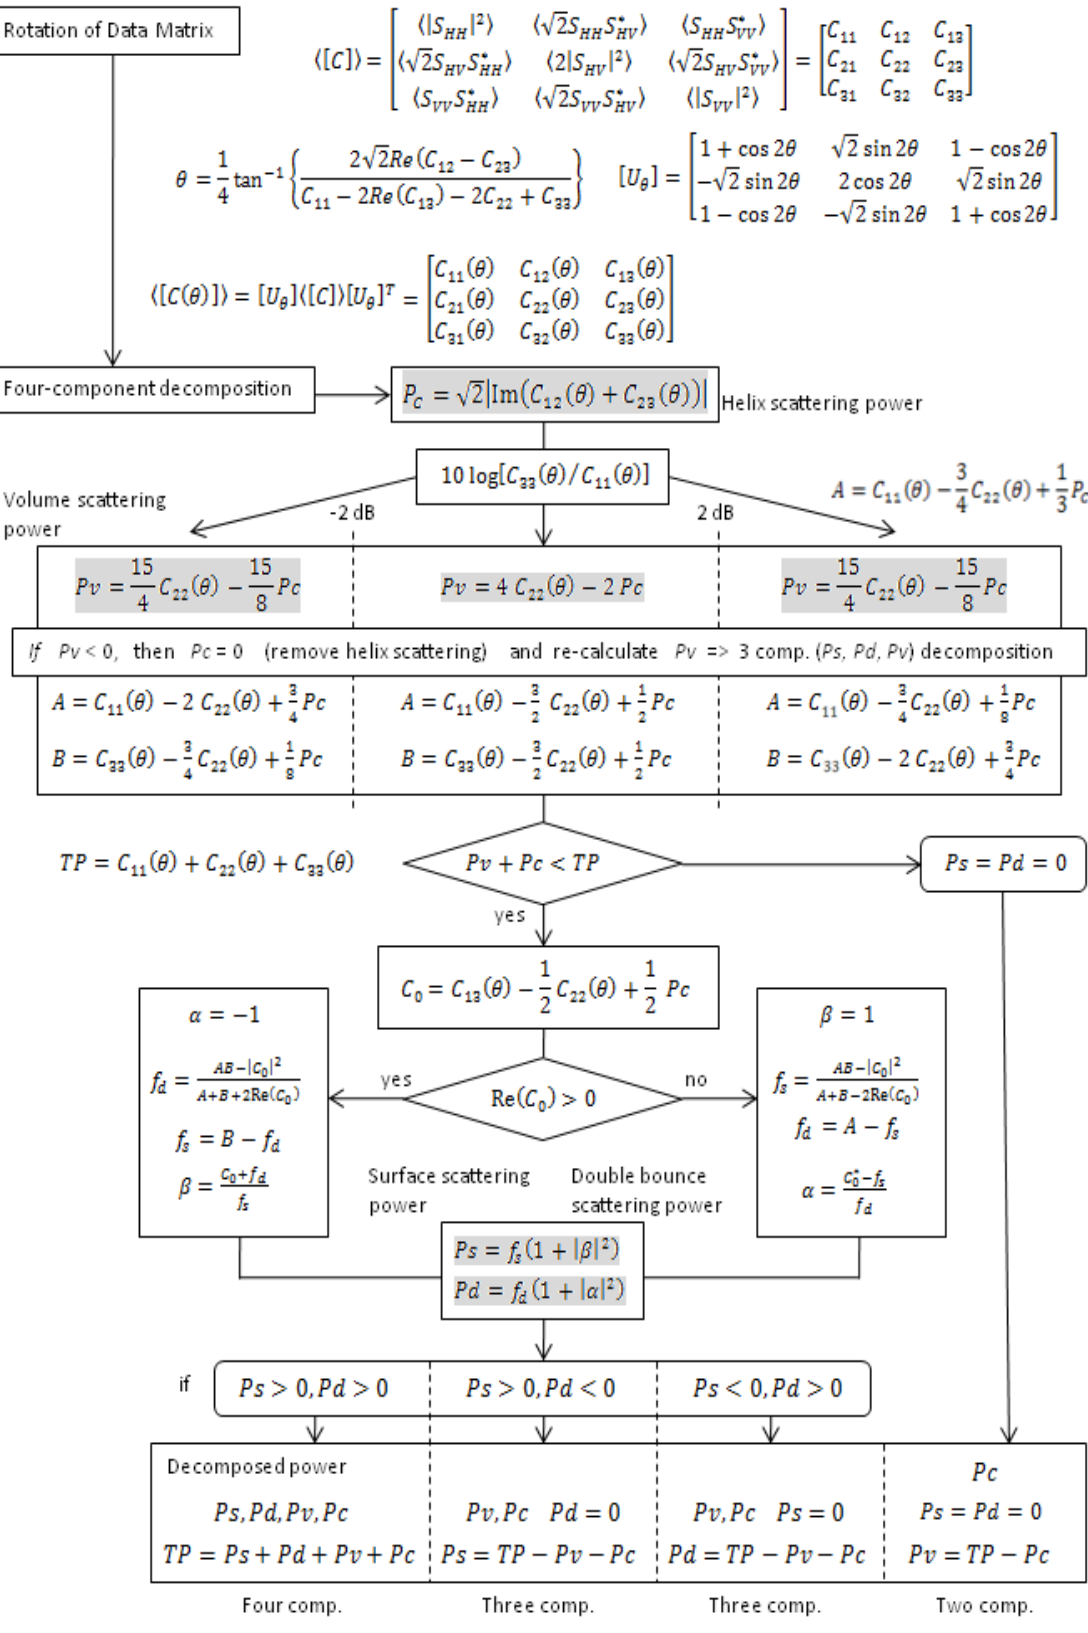
Figure 1. 4-CSPD algorithm using rotation of covariance matrix (the structure of entire flowchart mainly comes from